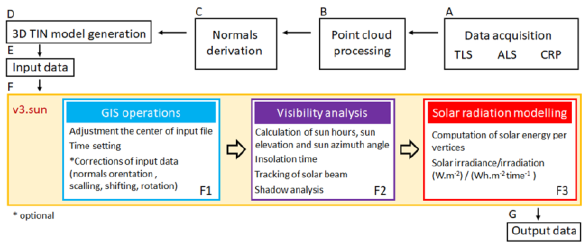
Figure 1. Methodological framework of solar radiation modelling proposed for v3.sun module prototype.